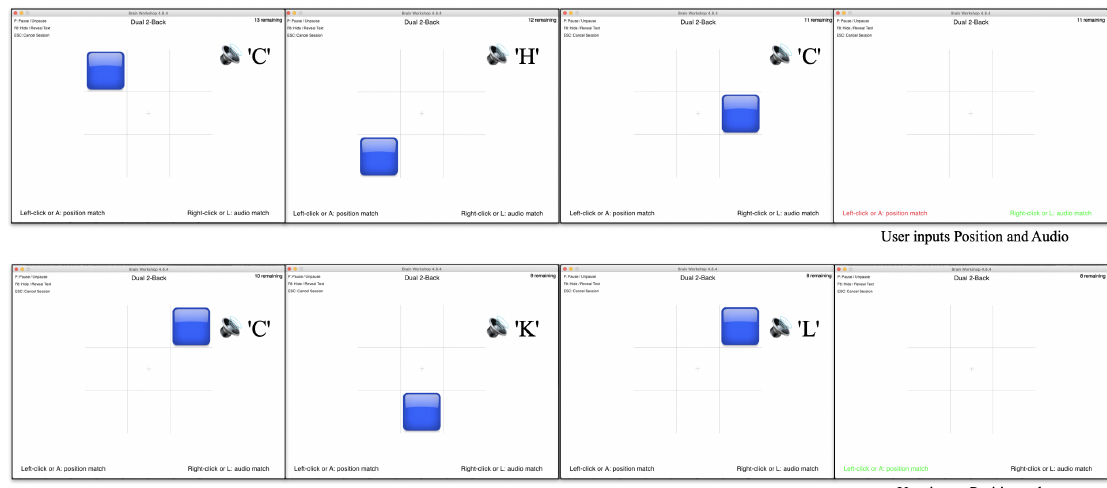
Figure 7. Example of the brain workshop running a dual 2-back test. The stimuli are shown for half a second, every three seconds. The participants need to indicate within the 3-s window if the position or audio matches the 2nd (or N-th) previous stimuli. The writings at the bottom of the program indicates whether participants’ inputs are correct by turning green or wrong by turning